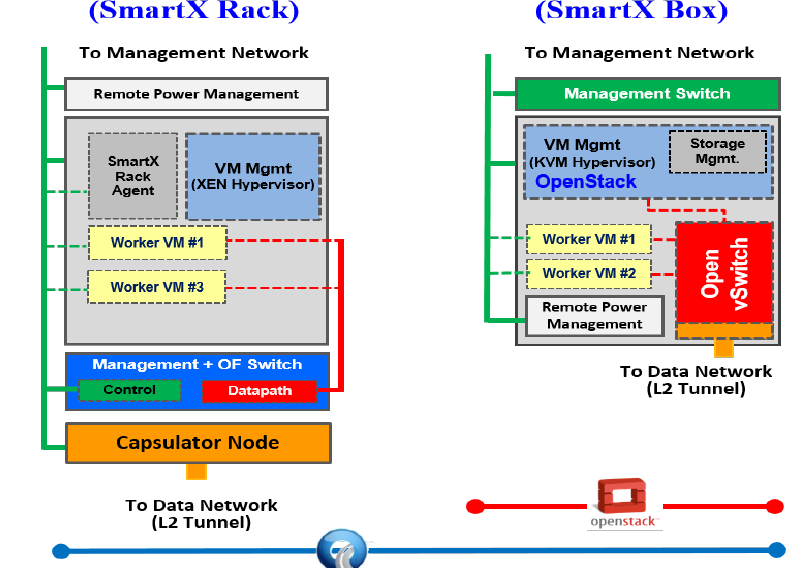
Figure 1. SmartX Rack versus SmartX Box Comparison.